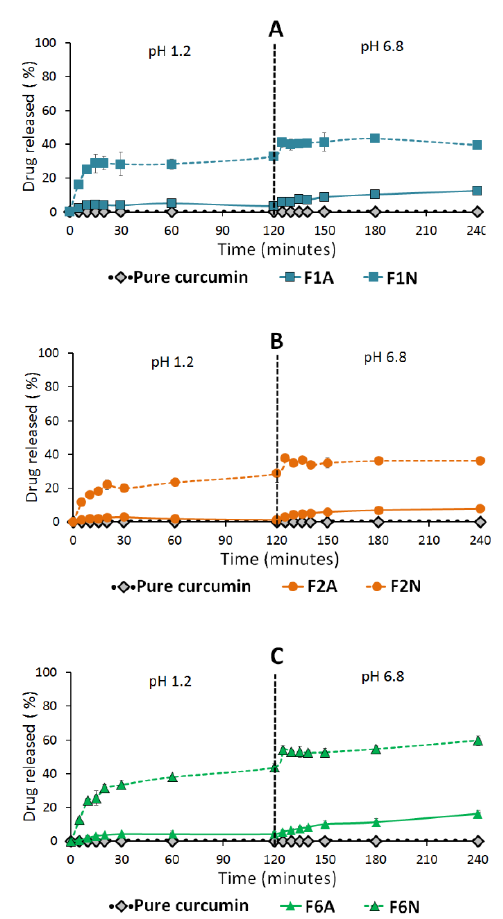
Figure 12. Influence of adsorbent type on curcumin release from solid SNEDDS. ( A ) Denotes F1, ( B ) F2 and ( C ) F6 solidified SNEDDS. The dashed line indicates the time point at which the dissolution media was shifted from pH 1.2 to pH 6.8. Data are expressed as mean ± SD. Details of the formulation compositions are presented in Table 6.